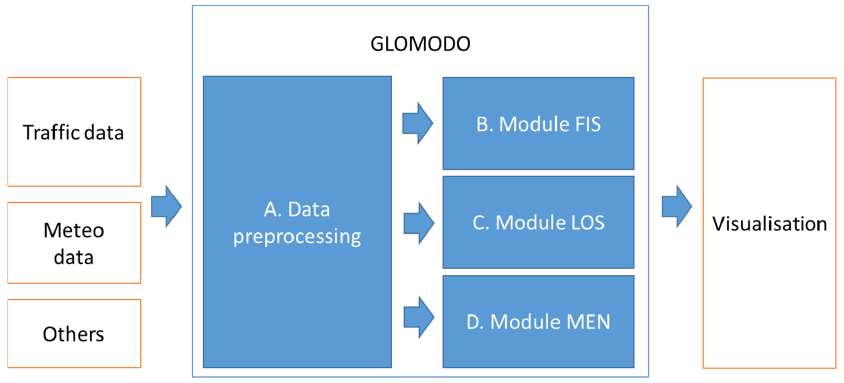
Figure 3. Main modules developed within the project GLOMODO.